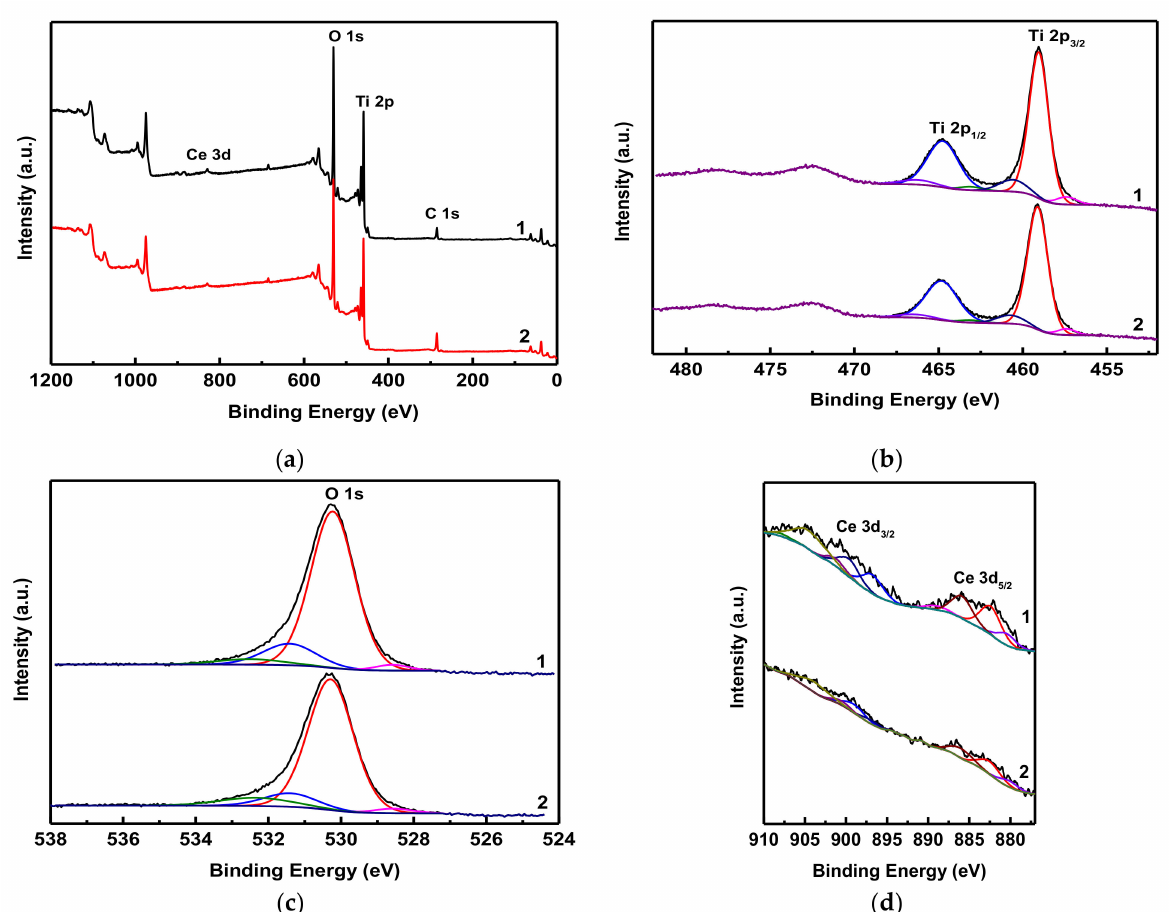
Figure 7. XPS survey spectra ( a ), Ti 2p XPS spectra ( b ), O 1s spectra ( c ), and Ce 3d region ( d ) of the TiO 2 –5% Ce sample before (1) and after (2) the